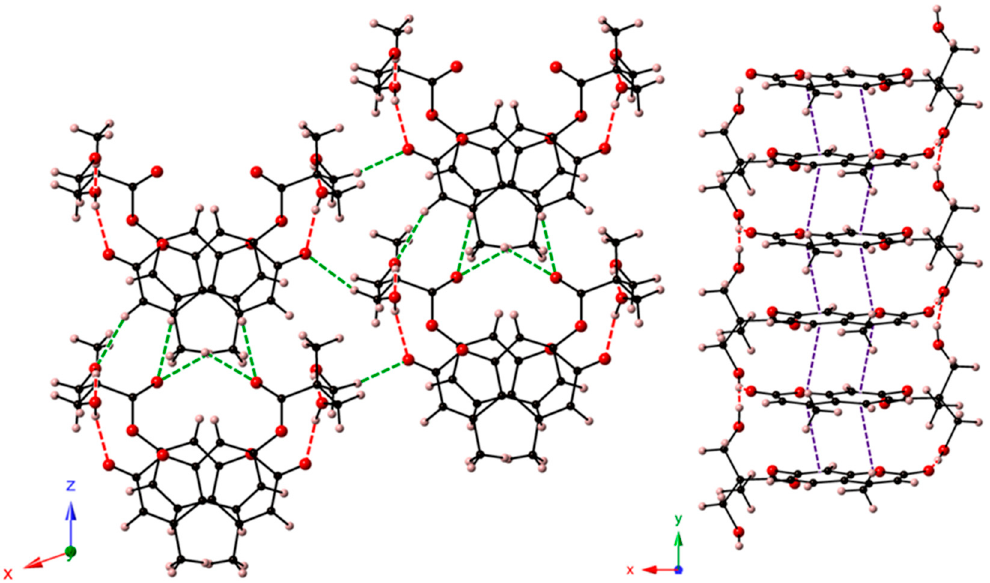
Figure 9. View of the crystal packing of DHMC along the crystallographic y axis ( left ) and detail of the supramolecular one-dimensional arrangement ( right ).